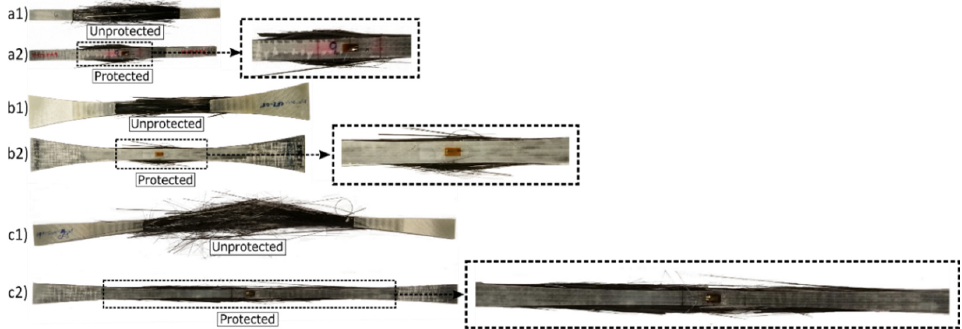
Figure 13. Examples of failed unprotected and protected carbon composite specimens: ( a1 , a2 ) straight-sided, ( b1 , b2 ) butterfly, and ( c1 , c2 ) X-butterfly.